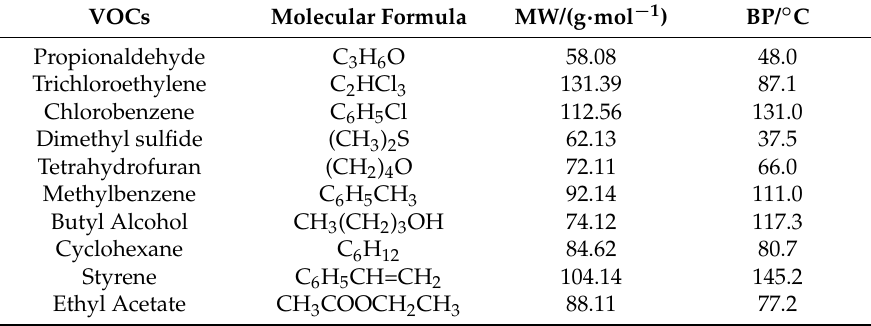
Table 1. Properties of the 10 volatile organic compounds (VOCs) used in toxicity